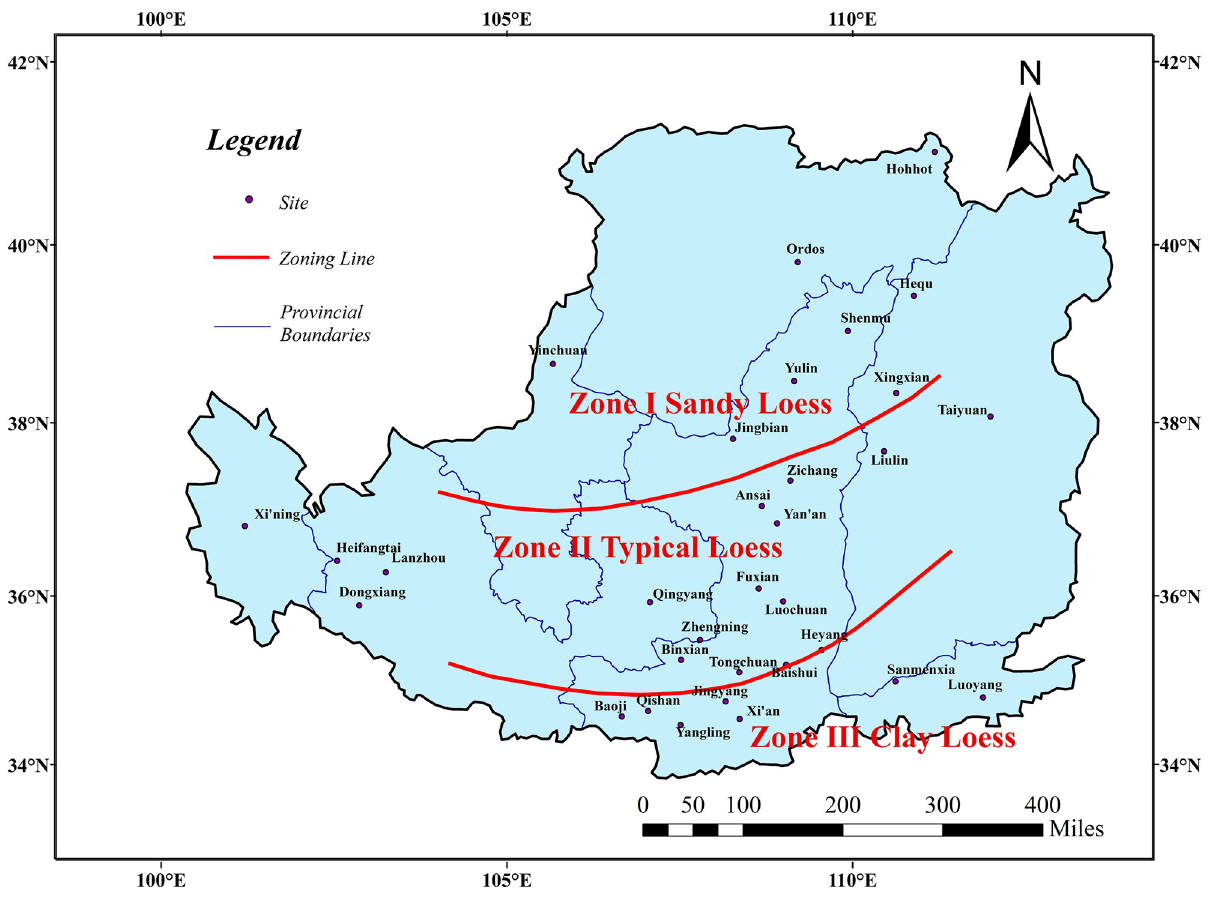
Fig 2. The zoning of the Chinese Loess Plateau(Only the boundary of the Loess Plateau comes from Huang [32], illustrative purposes only).